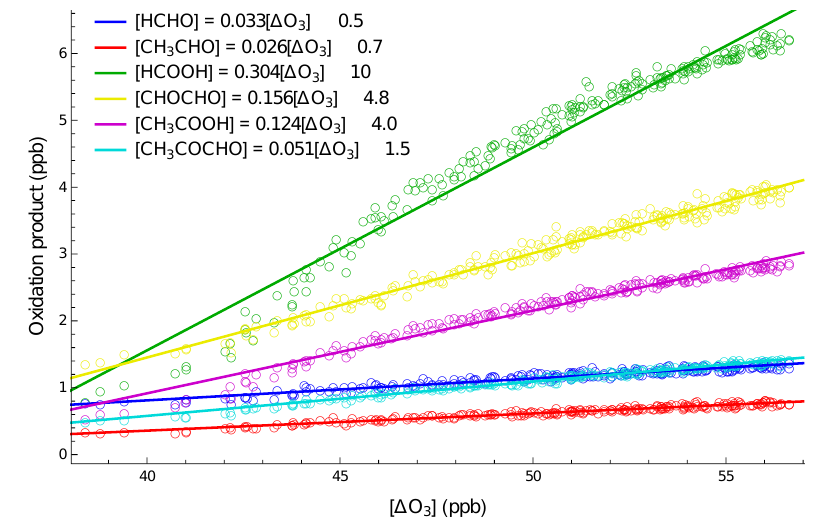
Figure 4. Determination of gas-phase product yields in experiment 5. Table 3. Gas-phase molar yields (%) for major α -phellandrene ozonolysis products.